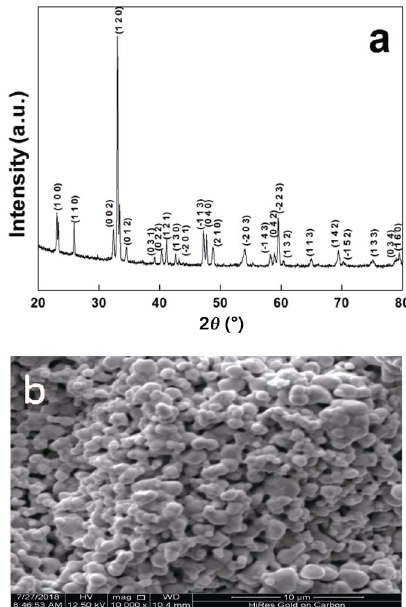
Fig. 1 (a) Room-temperature XRD pattern and (b) SEM image of Sm 2 NiMnO 6 . Table 1 Comparison of observed d obs and calculated d Cal , and d values of Sm 2 NiMnO 6 with